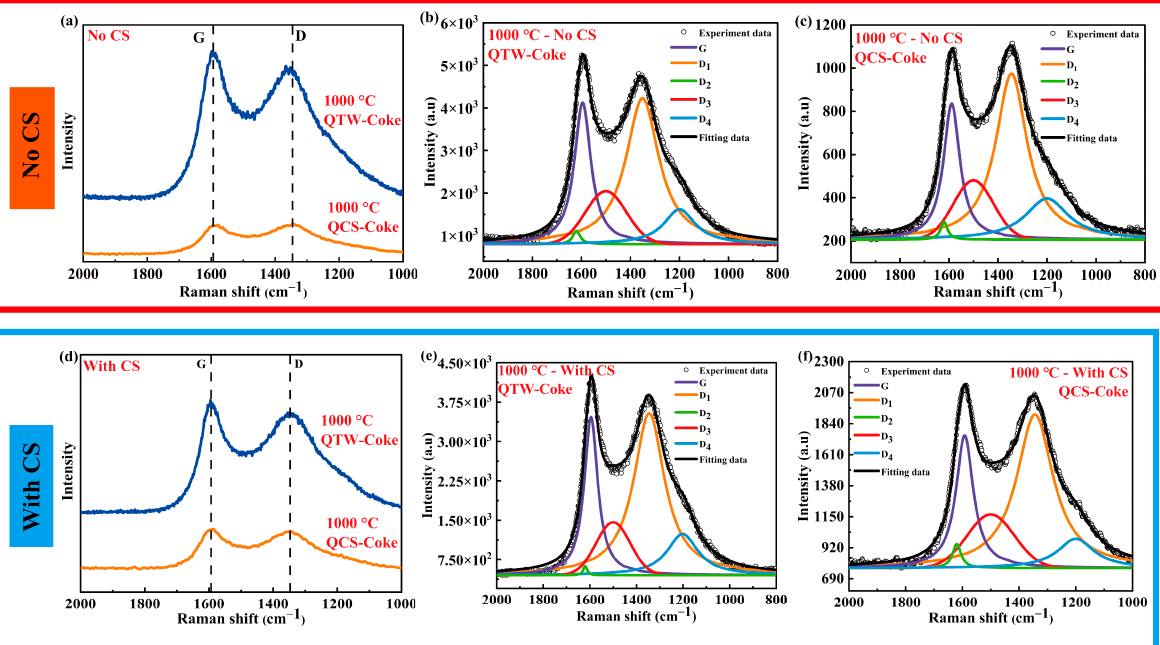
Figure 8. Raman spectra and fitted bands of coke at 1000 °C: ( a – c ) no CS, ( d – f ) with CS.